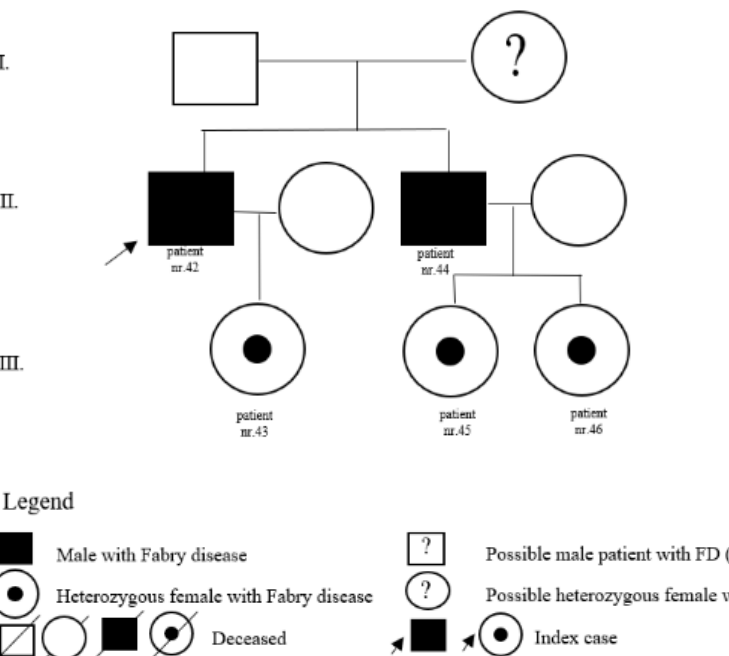
Figure 7. Pedigree of family with GVUS c.427G>A (p.Ala143Thr).